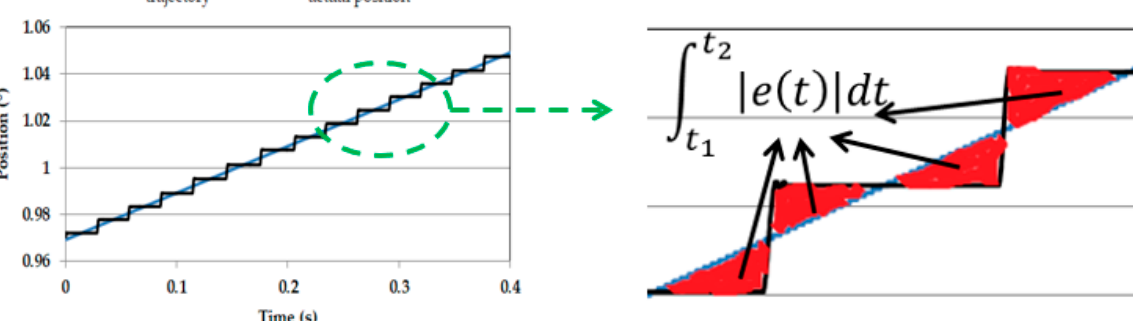
Figure 8. Trajectory and actual motor position at velocity of 0.2 °/s with summation of absolute value deviations.